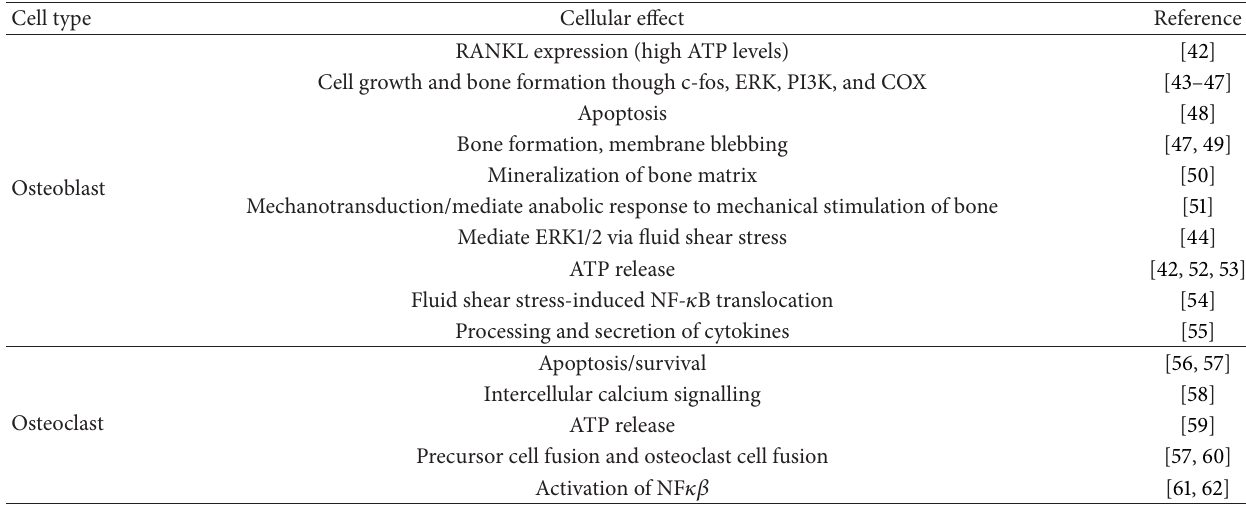
Table 2: Published effects of P2X7 receptors in immune